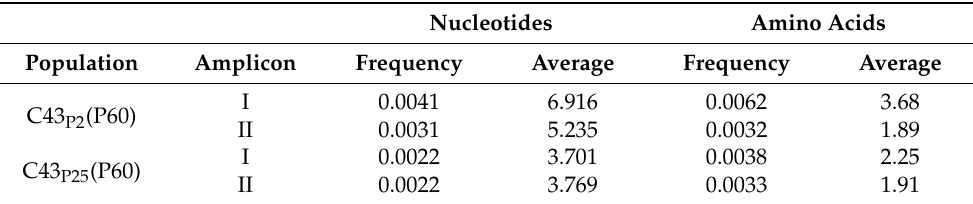
Table 3. Mutation frequency in the ensemble of sequences and expected average number of mutations per sequence (nucleotides and amino acids) in the whole protein. Different phenotypes carry multiple amino acid changes when compared to the most abundant protein sequence in the